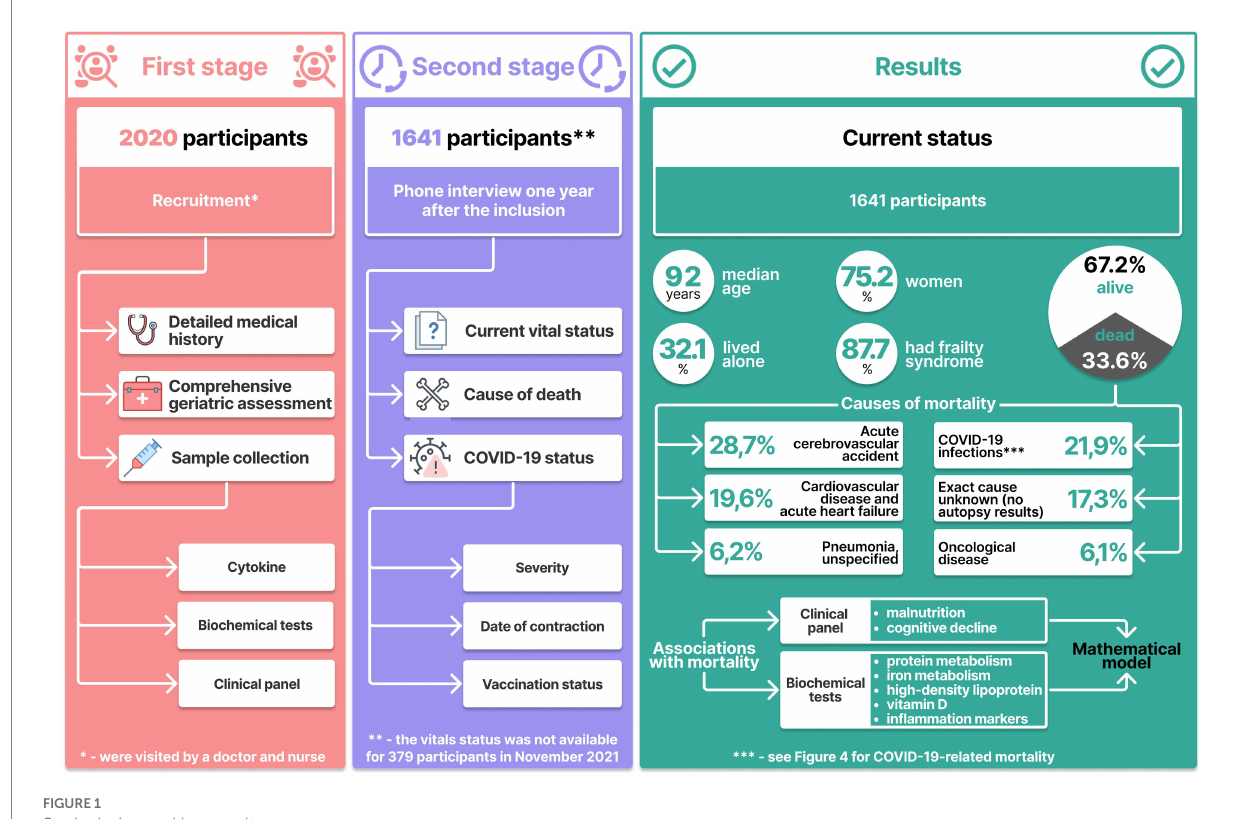
FIGURE 1 Study design and key